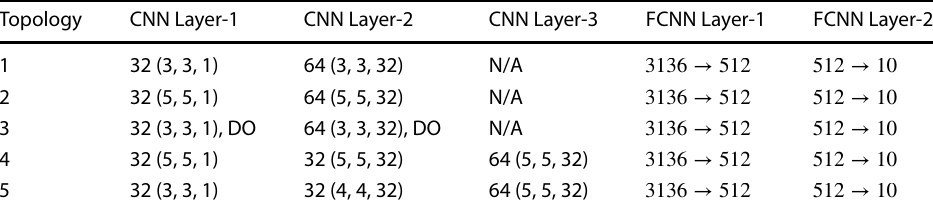
Table 3 Network topologies— second method